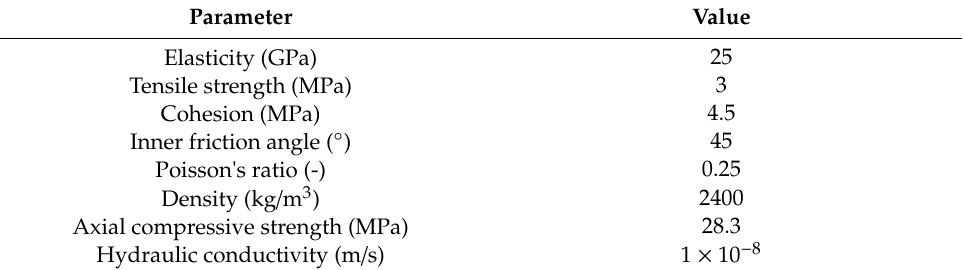
Table 1. Mechanical properties of the lining